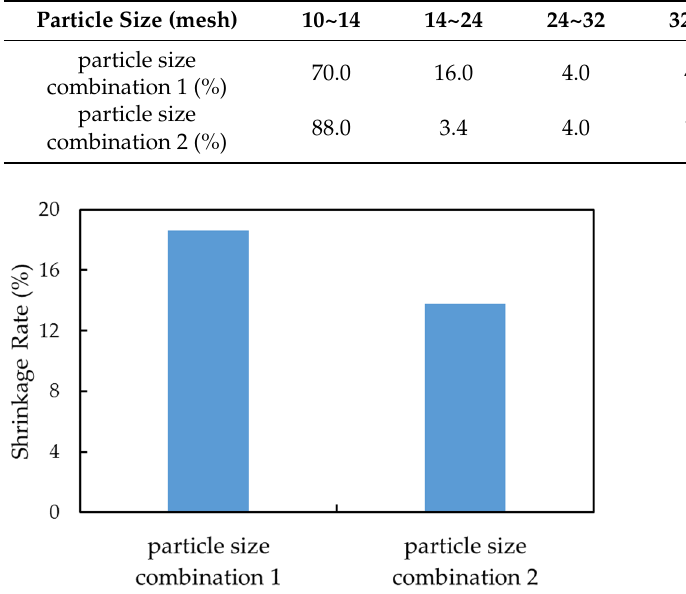
Figure 8. Relationship between shrinkage rate and particle size combination of PAC30.